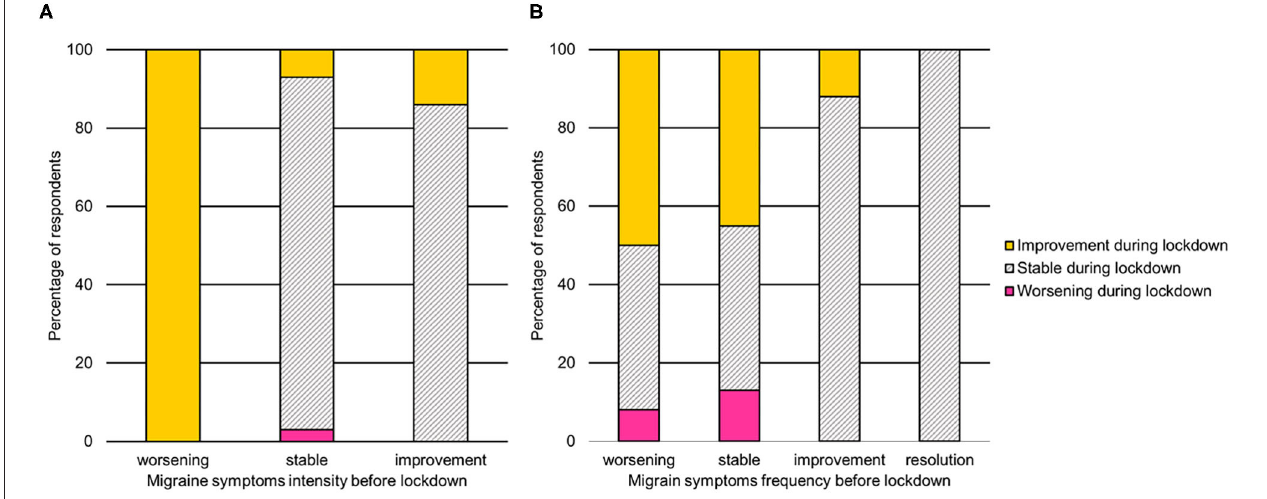
FIGURE 1 | Association between migraine symptoms intensity (A) and frequency (B) before and during the lockdown. Note. The symptoms severity before lockdown is reported on the x-axis, whereas the symptoms severity during the lockdown is reported using color